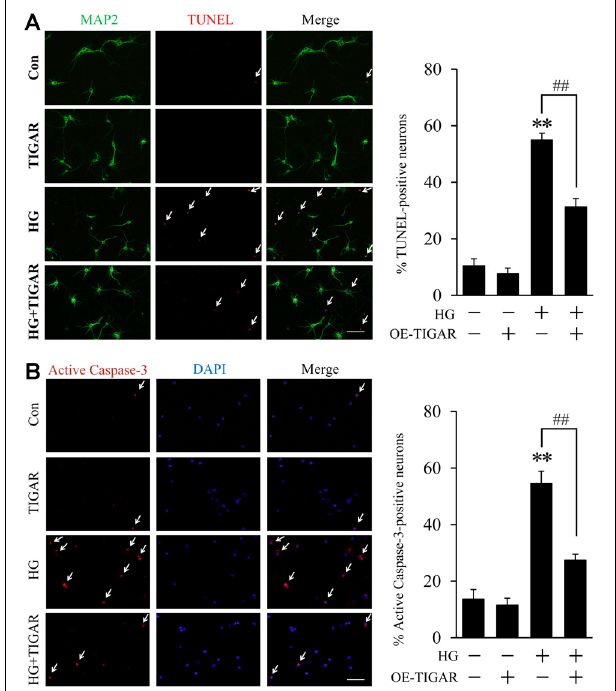
FIGURE 2 | TIGAR reduced high glucose-induced neuronal apoptosis. (A) TUNEL and MAP2 staining and quantification of TUNEL-positive primary neurons in each group ( n = 9 per group). (B) Immunofluorescent staining of active Caspase-3 and quantification of active Caspase-3-positive cells in each group ( n = 9 per group). Scale bar = 50 µ m. ∗∗ p < 0.01 vs. the control group, ## p < 0.01 vs. the high glucose (HG) group, two-way